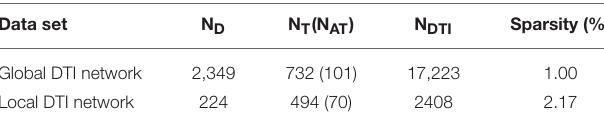
TABLE 1 | The statistics of global drug-target interactions (DTI) network and local DTI network for natural products. Data